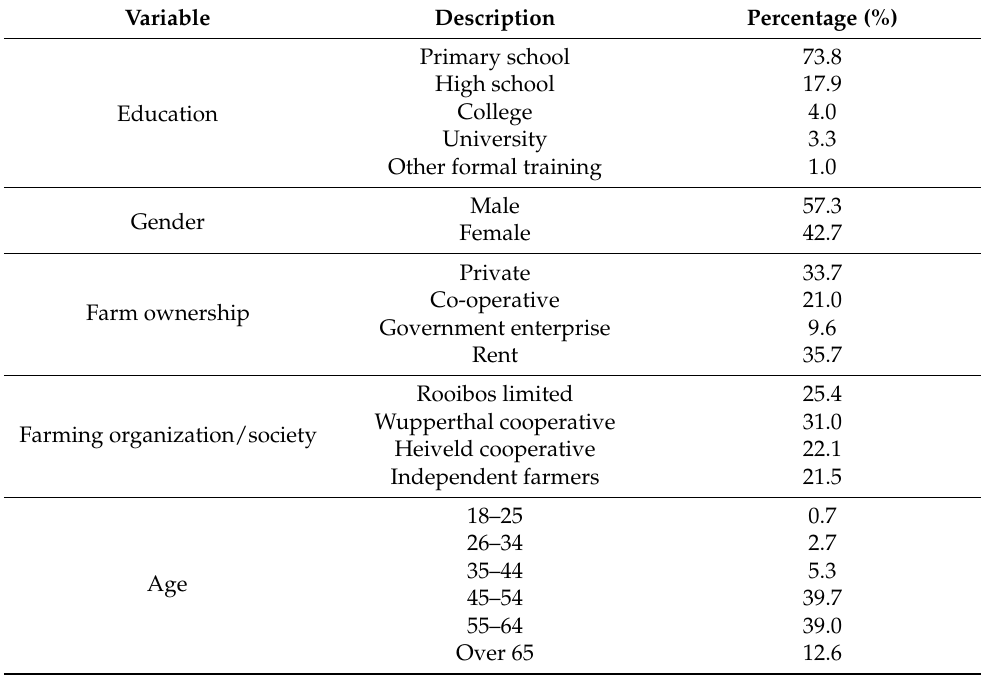
Table 2. Participant demographic